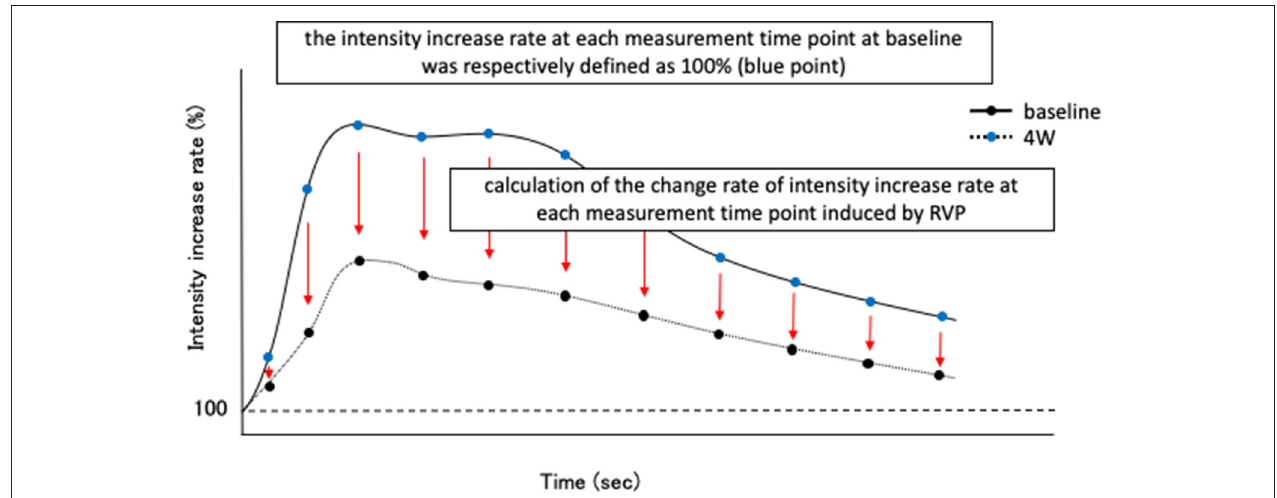
FIGURE 1 | Schematic diagram of evaluation method of intensity reduction level due to rapid ventricular pacing (RVP) in contrast-enhanced ultrasonography (CEUS). First, before initiating RVP (baseline) in both control group and pimobendan group, the intensity increase rate at each measurement time point after Sonazoid ® administration (in this study, from 0 to 300s) was respectively defined as 100% (blue point). Then, the change rate of intensity increase rate at each time point at 4 weeks after initiating RVP (4 weeks) was